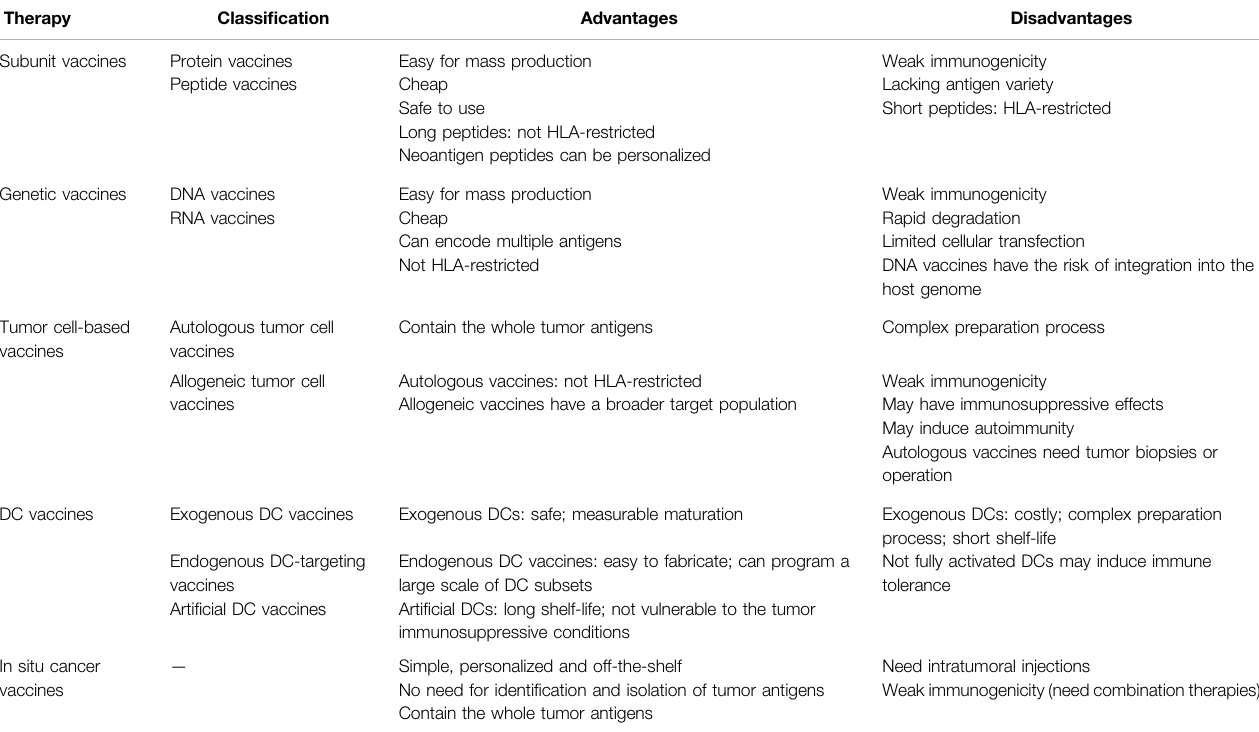
TABLE 1 | Characteristics of conventional cancer vaccines and in situ cancer